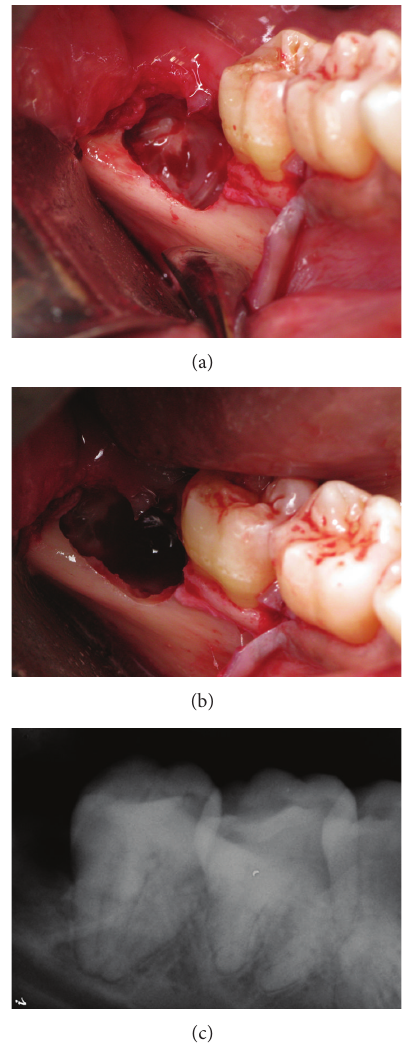
Figure 2: Lower right MTM: (a) after amputation of the crown, rotary instruments were used to reduce the distoocclusal section of the remaining stump; (b) after an additional cut and sectioning of the mesial portion of the tooth; (c) sufficient clearance to the second molar